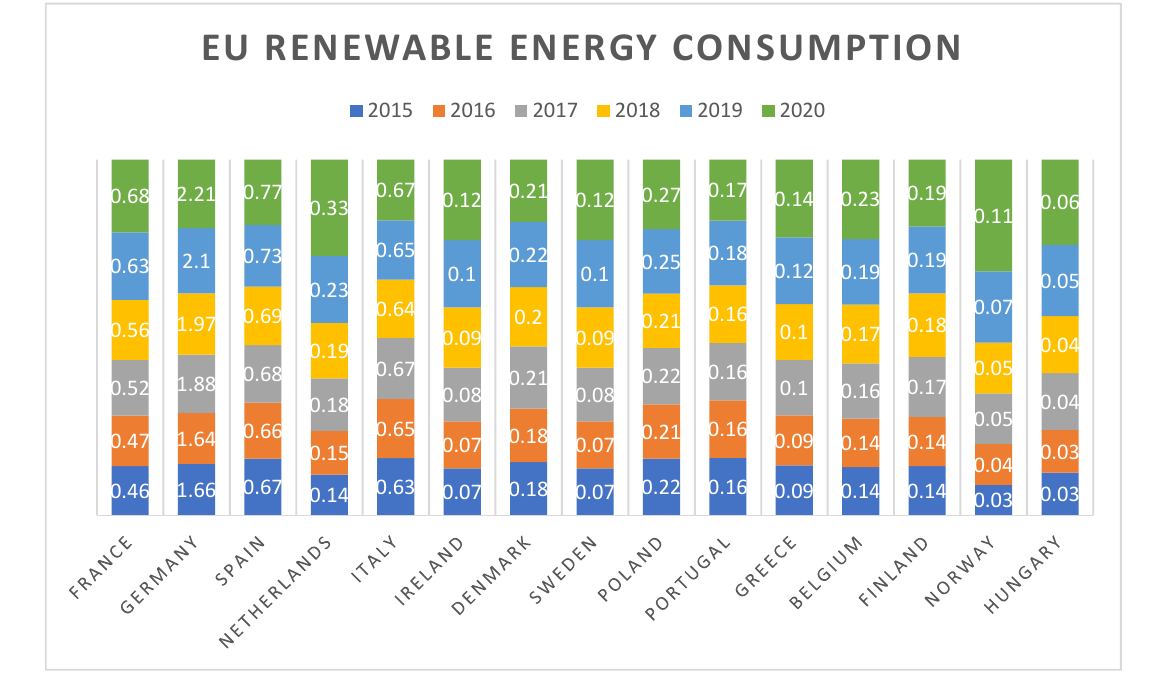
Figure 4. EU renewable energy consumption 2015–2020.